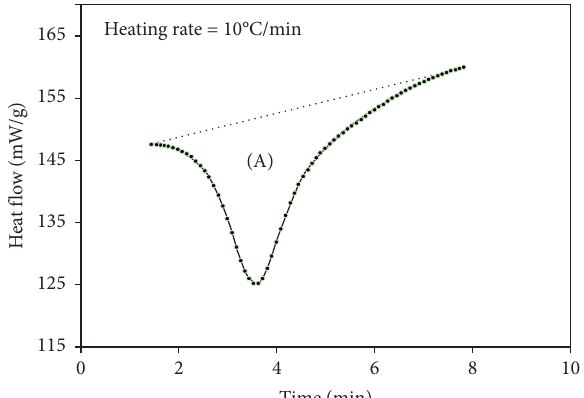
Figure 5: Trace of a DSC thermogram obtained at a heating rate of 10 ° C/min within the temperature range 70–220 ° C for NBR compound.